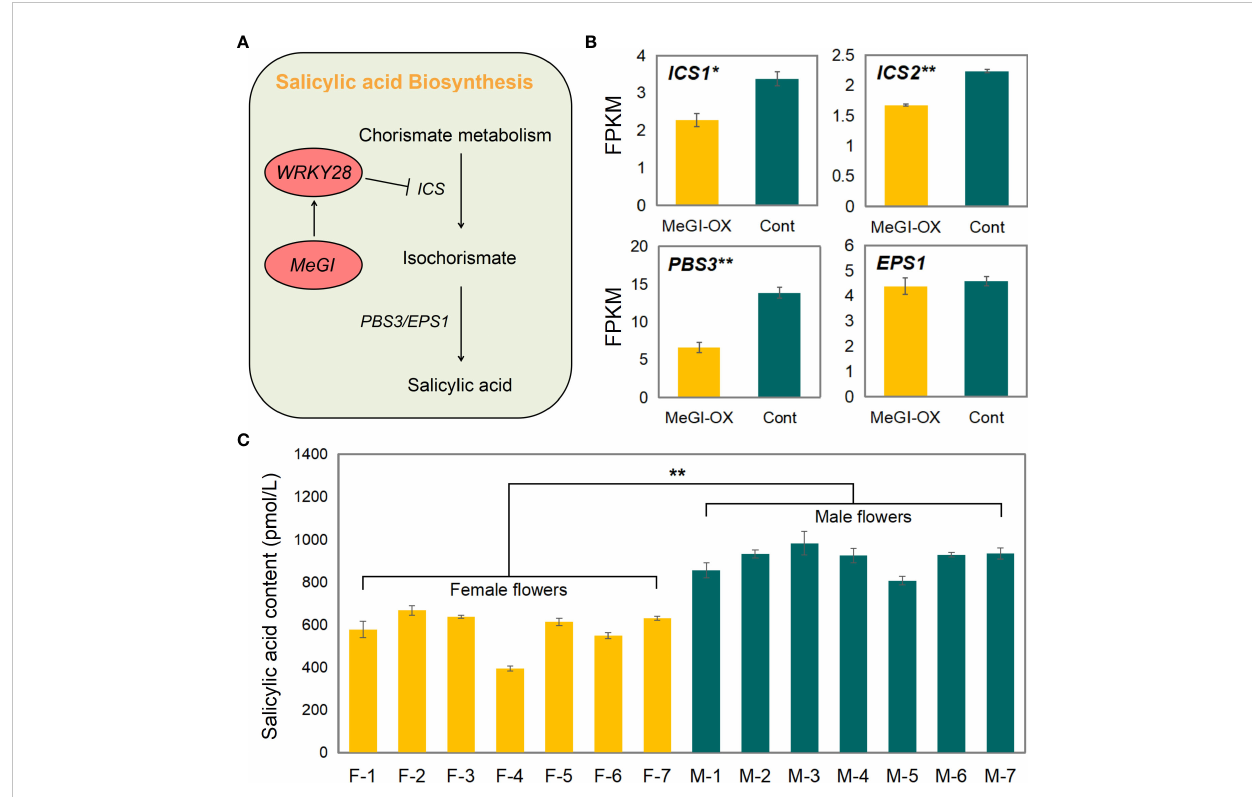
FIGURE 7 SA biosynthetic pathway and SA content. (A) Representative genes in the SA biosynthetic pathway and the model for regulation of SA biosynthesis by WRKY28 . (B) Expression levels of ICS1, ICS2 , PBS3 , and EPS1 in the MeGI-OX and control lines. Bars indicate standard errors. (C) SA content in female and male D . oleifera fl owers. Bars indicate standard errors. '*' represents signi fi cant difference (P < 0.05), and '**' represents extremely signi fi cant difference (P <